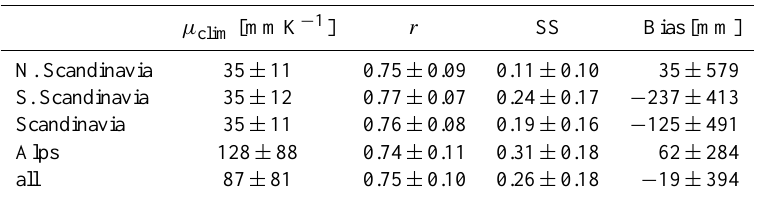
Table 2. Summary of the model parameters and validation results of the climatologically derived model. All numbers given are the mean values with their standard